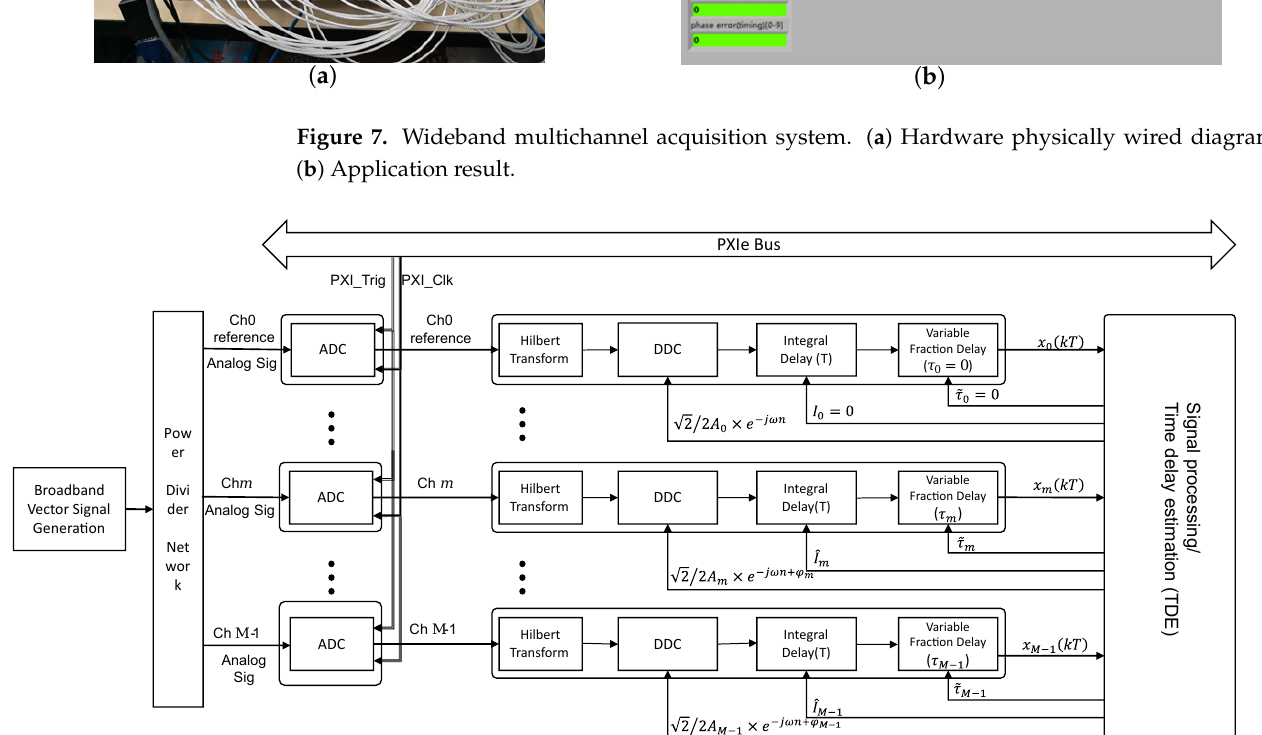
Figure 8. Signal-processing block